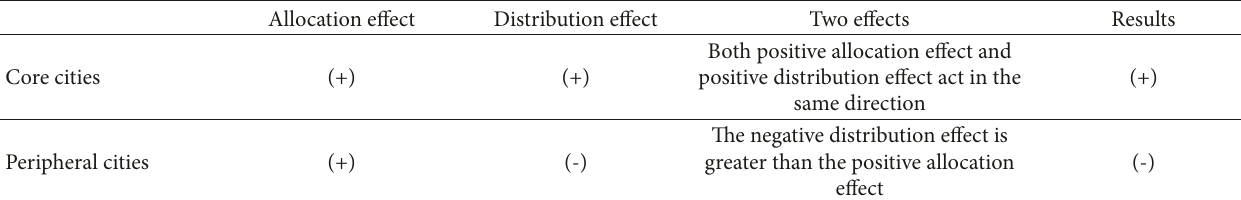
Table 11: Comprehensive analysis of allocation effect and distribution